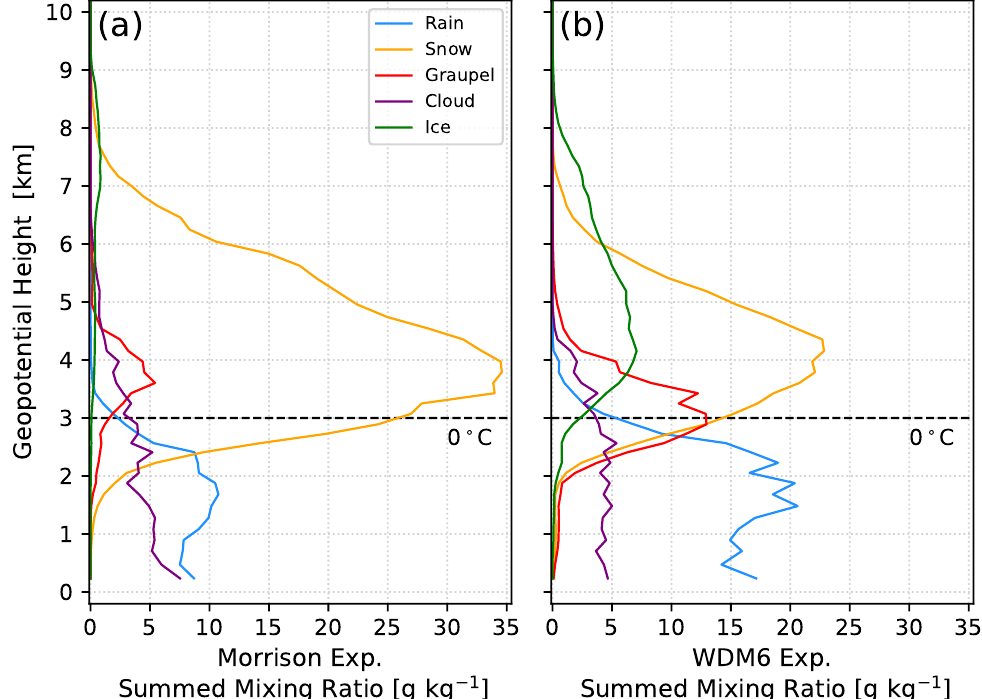
Figure 10. Profiles of hydrometeor mixing ratio (g kg − 1 ) along the tangent point locations of occultation g03r (pink curve in Figure 4). The values shown are the summation along the ray path corresponding to each tangent point for each hydrometeor type in the ( a ) Morrison and ( b ) WDM6 experiments, plotted at the height of the tangent point. The black dashed line indicates the freezing level in the corresponding